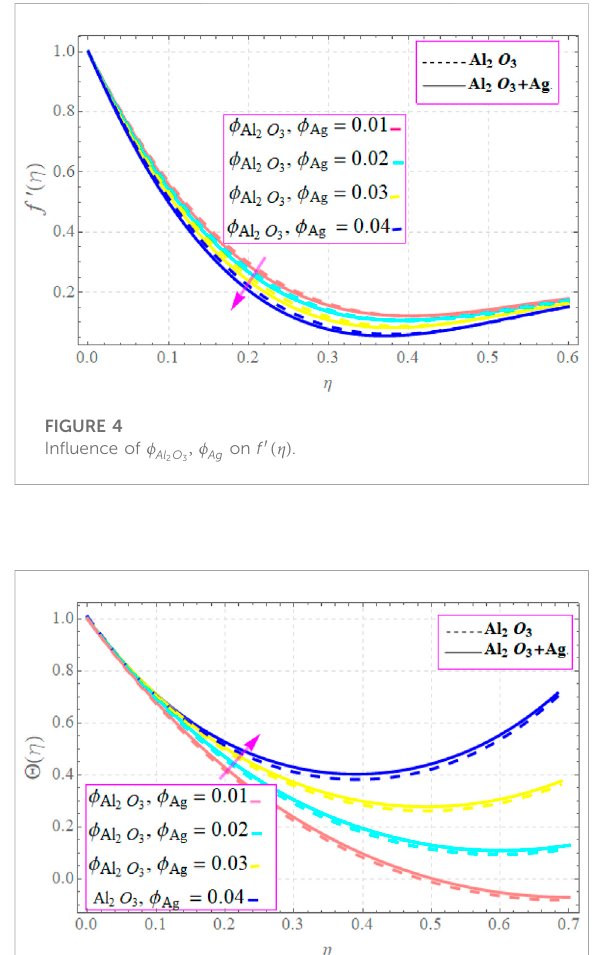
FIGURE 8 In fl uence of Gr on f ′ ( η )